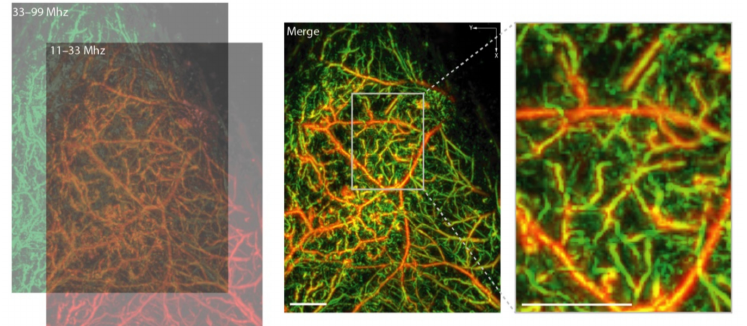
Figure 3. Raster-scanning optoacoustic mesoscopy enables a precise visualization of microvasculature. Depending on the detection frequencies, larger (11–33 MHz, in red) or smaller (33–99 MHz, in green) vessels can be resolved. White square indicates magnified area. Scale bar indicates 1